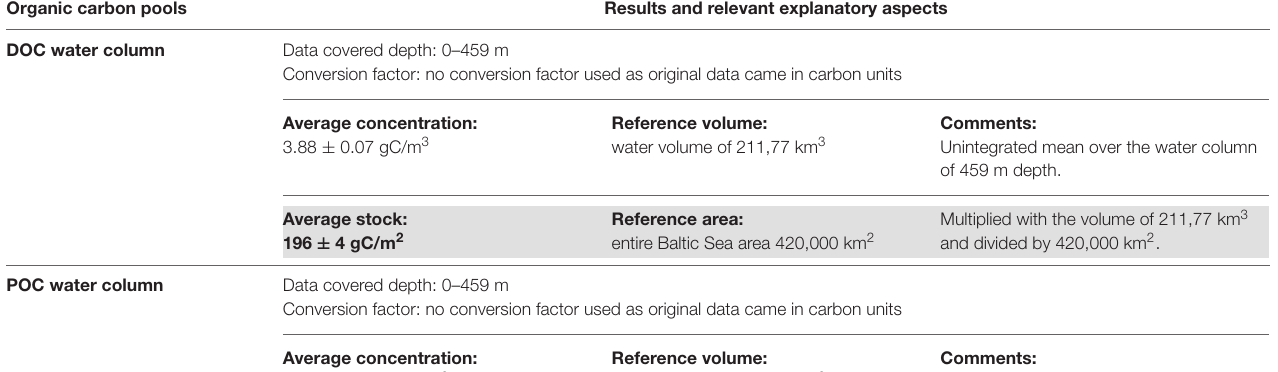
TABLE 2 | Organic carbon concentration and stock estimates with the associated uncertainties in gC/m 3 and gC/m 2 for the identified organic carbon pools with references volumes and areas and explanatory aspects. Organic carbon